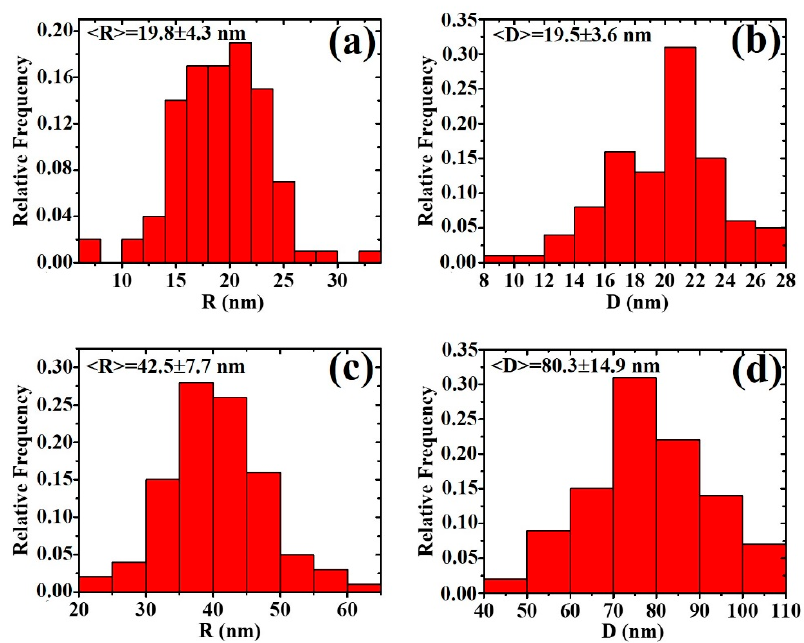
Figure 5. Representative size distributions for Au / Pd clusters: ( a , b ) distributions for width R and length D, respectively, of Au / Pd clusters in deposited film of h = 2.8 nm thickness; ( c , d ) distributions for width R and length D, respectively, of Au / Pd clusters in deposited film of h = 5.2 nm thickness. In each case, mean values of width < R > and length < D > , as extracted by the distribution, are reported.